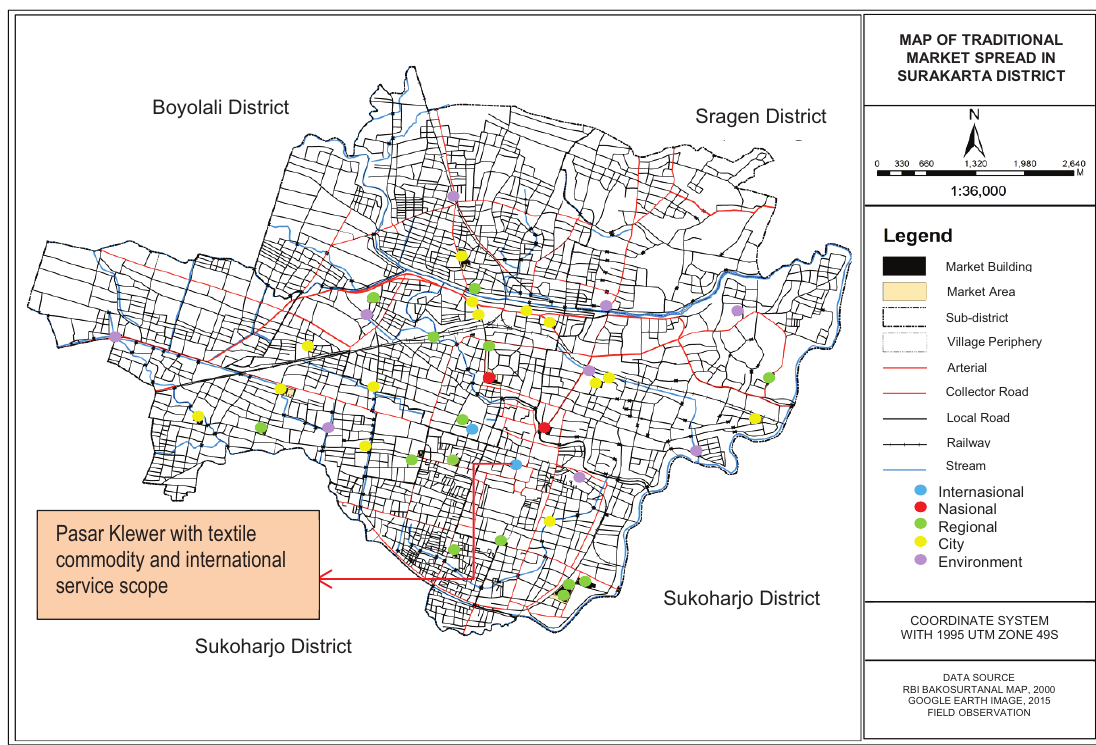
Figure 2. Scope of traditional markets in Surakarta district (Aliyah et al., 2017a)